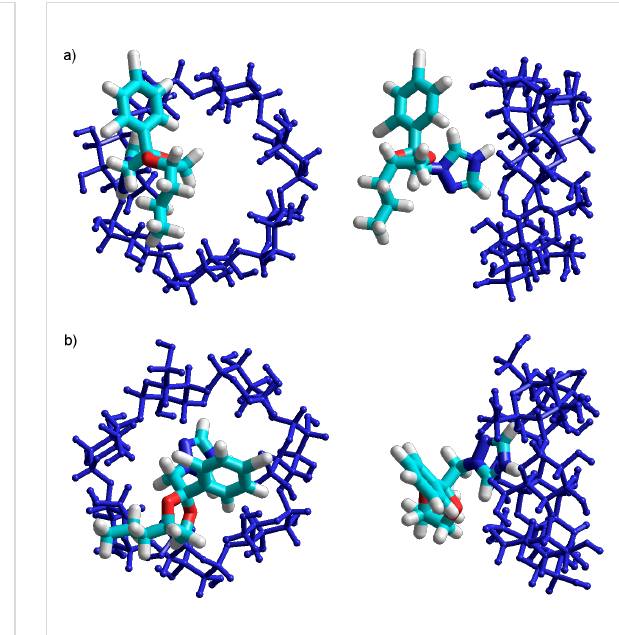
Figure 8: PM3 optimized molecular geometry of β -CD/PPH + inclusion compounds in the (a) A and (b) B configurations.